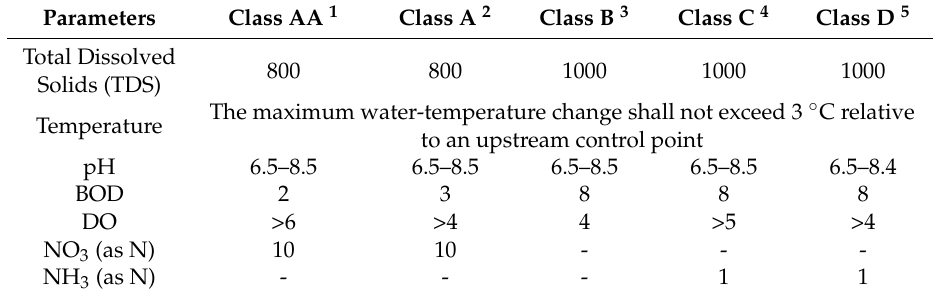
Table 4. National Environment Quality Standards/National Surface Water Classification Criteria [61].